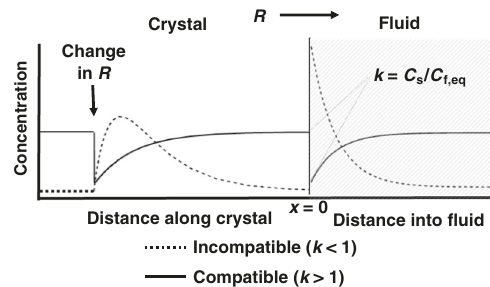
Fig. 5 Trace element response due to changes in growth rate. Shown is a conceptual diagram of how crystal growth rate ( R ) affects trace element distributions associated with a sudden change in growth rate. The fi gure shows the transient case in which growth rate suddenly increases from a previous steady state. The concentration ( C ) in the fl uid near the crystal rises or falls, depending on the element ’ s compatibility ( k , the equilibrium ratio of the solid concentration to the liquid concentration), which is recorded in the crystal as an enrichment or depletion in the crystal, respectively. If the growth rate stays constant, the fl uid concentration will eventually reach a new steady state, which will be re fl ected in a constant C in the crystal as a function of distance, as distance represents time. The concentration pro fi le in the fl uid at steady state will represent a static chemical boundary